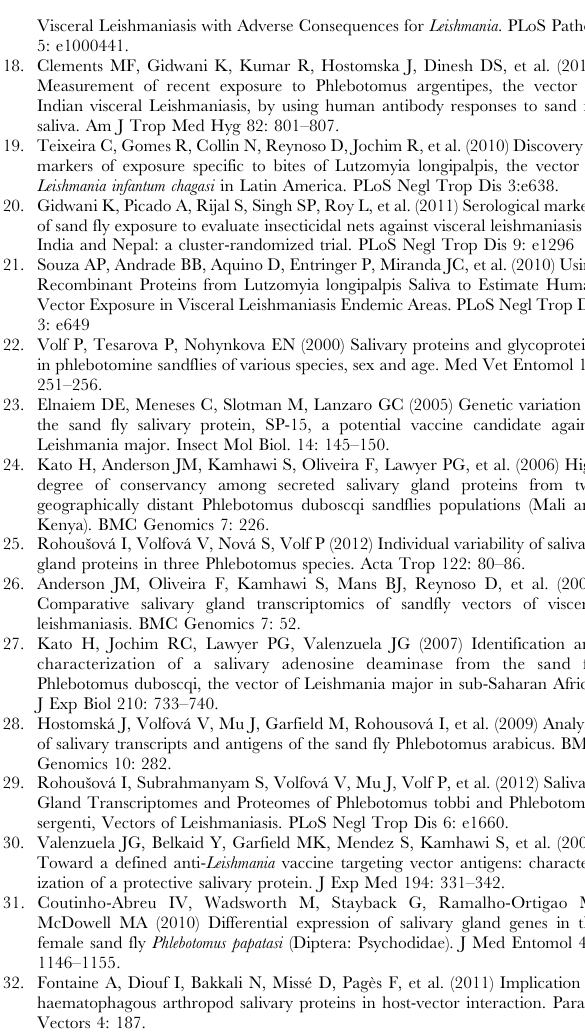
Figure S2 Competition assay using ELISA test. Ten sera from donors with specific antibodies against total salivary gland extract (SGE) were pre-incubated with the recombinant proteins PpSP32 at 10 m g/ml and then tested by ELISA against